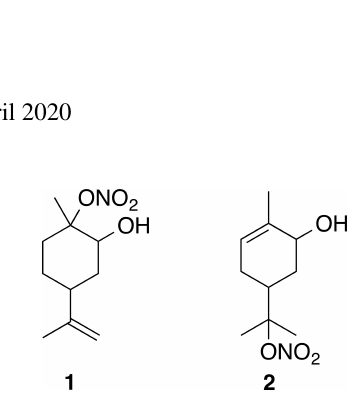
Figure 1. Two hydroxynitrate esters with available spectral data. Relative stereochemistry is